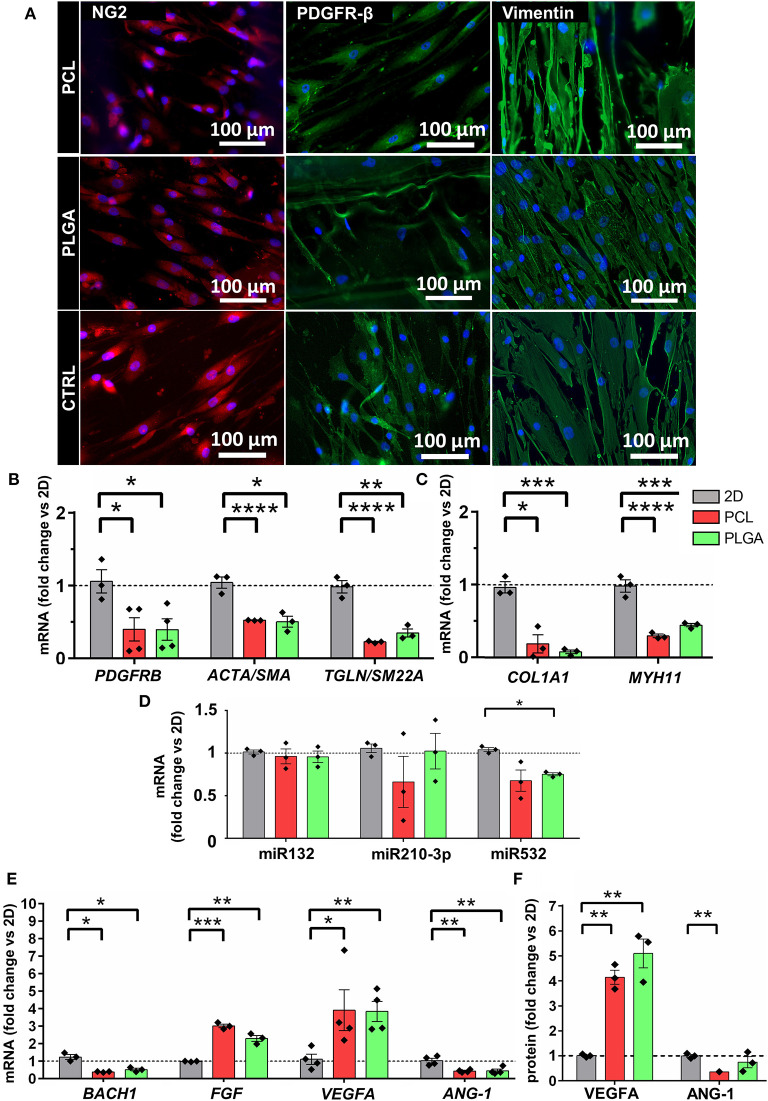
Effect of 3D culture on poly(ε-caprolactone) with gelatin nanofibers (PCL-GL) and polylactic-co-glycolic acid with gelatin nanofibers (PLGA-GL) on APCs. Bar graphs show the average of 3 biological replicates comparing the 3D conditions to the 2D monolayer culture on petri dish. (A) Representative fluorescence images of specific phenotype markers (NG2, PDGFR-β and Vimentin) in APCs seeded, respectively, on PCL- and PLGA-based scaffolds; images showed that all the cells were positive for the indicated markers. (B,C) Expression of differentiation (PDGFRB, ACTA2/SMA, TGLN/SM22A, COL1A1, and MYH11) molecules. (D) Expression of angiogenic miRs: miR132, miR210-3p, and miR532. (E) BACH1, FGF, VEGFA, and ANG-1 molecules. (F) Bar graph shows the secreted of VEGFA and ANG-1. *p < 0.05, **p < 0.01, and ***p < 0.001 vs. 2D. Values are means ± SE, N = 3 biological replicates, each one with 3 technical replicates. ****p < 0.0001.